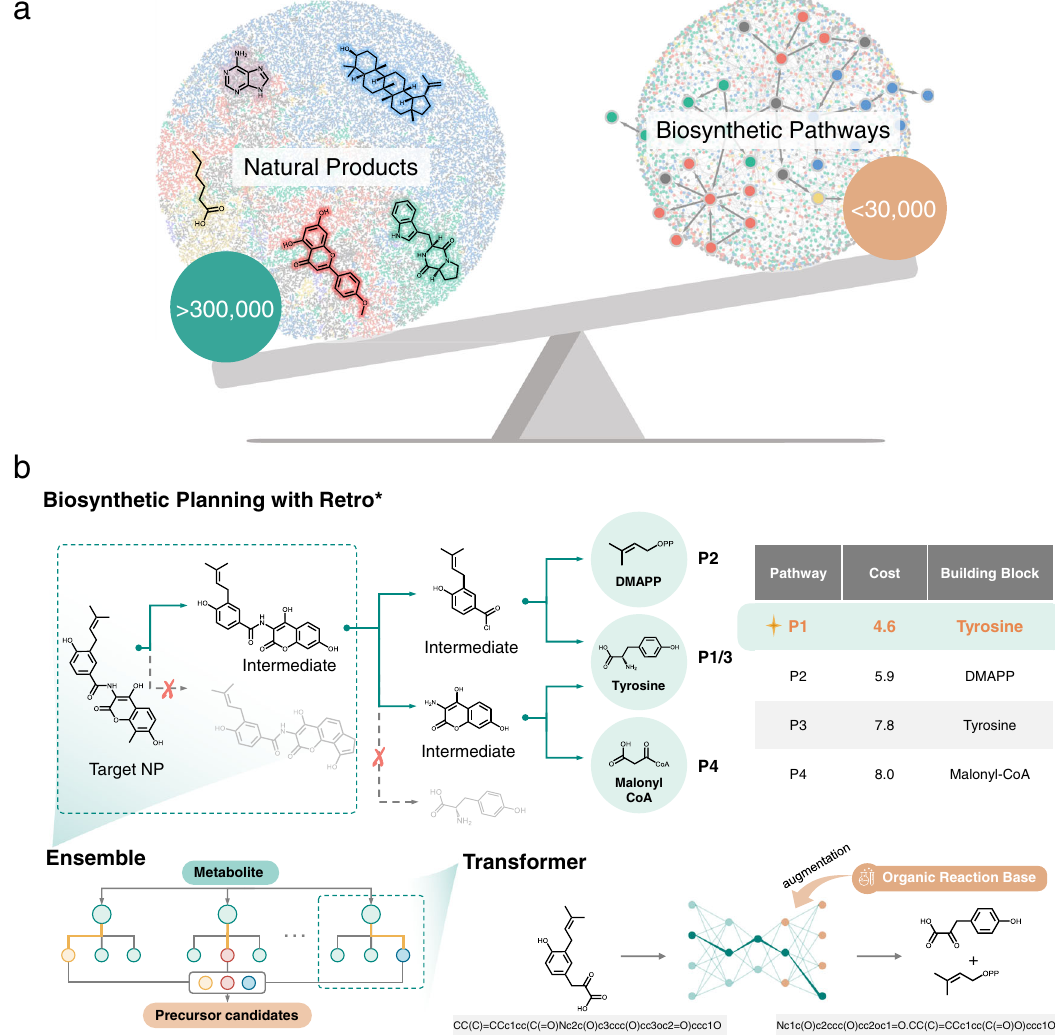
Fig. 1 The motivation and overview of BioNavi-NP. a The vast natural products and rare biosynthetic pathways reported to date. Natural products were collected from DNP 1 and visualized by TMAP 73 (left). Biosynthetic reactions were collected from MetaCyc 5 , KEGG 6 and MetaNetX 7 , and the network was visualized by Cytoscape 74 (right). The structures were represented by the nodes and similar structures converged. The edges and arrows in the biosynthetic network represent the structural transformation. Fatty acids and others from the AA/MA pathway were colored yellow. Terpenoids and steroids from the MVA/MEP pathway were colored blue. Flavonoids and others from the CA/SA were colored red. Alkaloids and others from the AAs pathway were colored green. Others, such as nucleic acids and some hybrid-origin compounds, were colored black. b The protocol of BioNavi-NP to explore biosynthetic pathways of target natural product. We trained the transformer neural networks by combining biosynthetic and organic reactions, and four models trained with different hyperparameters form the ensemble model, which was fi nally used to make the single-step prediction (see details in Methods, Supplementary Figs. 1 and